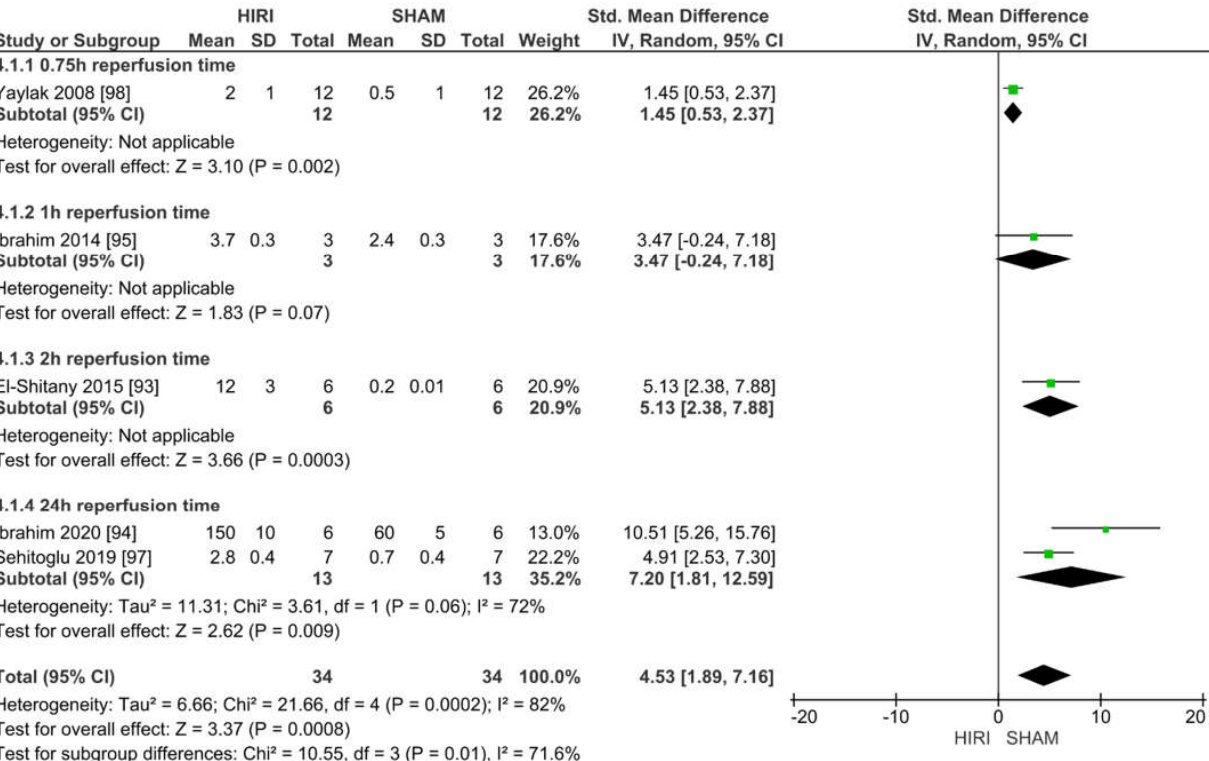
Figure 10. Forest plot of 100% HIRI in rats and 45 min warm ischaemia time grouped by reperfusion time between 0.75 and 24 h.